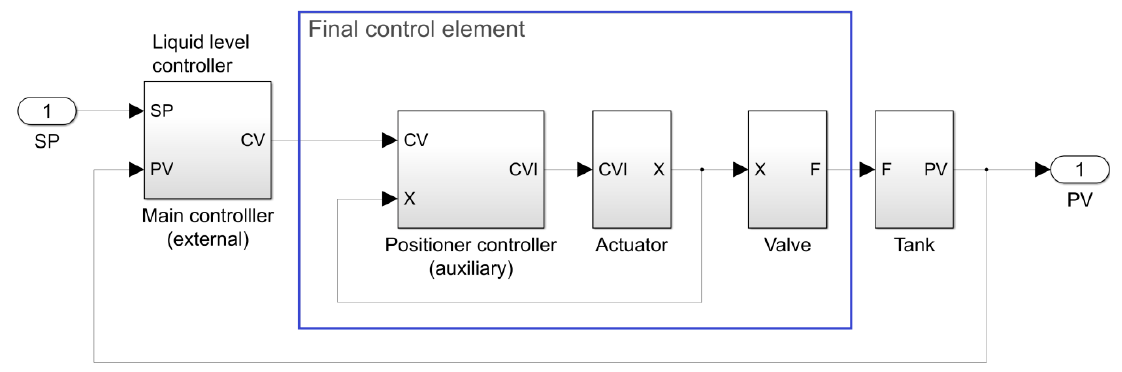
Figure 5. Simplified simulation model of the liquid level control system. Notions: SP—liquid level setpoint; PV—measured liquid level; CV—output of the main process controller; CVI—output of the internal positioner controller; X—position of the valve stem; F—liquid flow rate; and PV—liquid level in the tank.